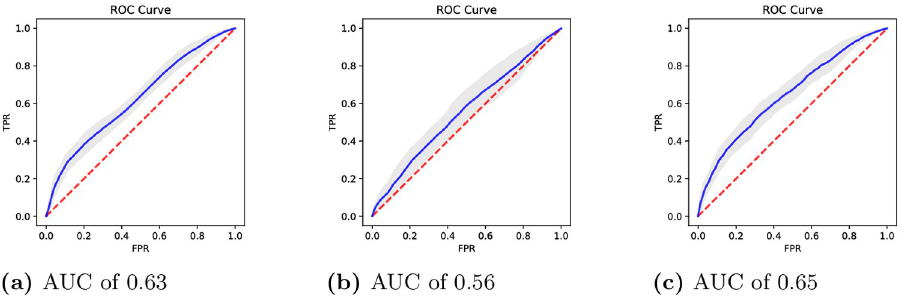
Fig 3. ROC curves of the GBDT model on the Tu¨EyeQ data set that was trained on (a) only the features related to eye-movements, (b) only the socio-demographic features, and (c) on the socio-demographic and eye-movement- related features. Standard deviations based on the 20 folds of cross-validation are shown in gray. (a) AUC of 0.63. (b) AUC of 0.56. (c) AUC of